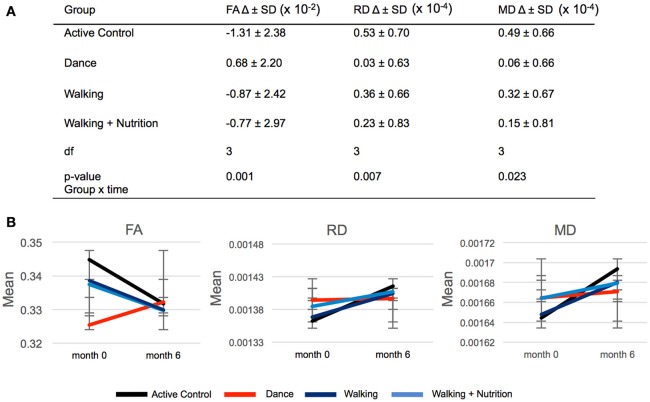
(A) Time × group interaction in diffusivity parameters in the fornix in the four intervention groups. SD, standard deviation; Df, degrees of freedom. (B) Graphic representation of changes (delta) in FA, RD, and MD during 6-months presented in (A). Error bars: standard deviation.